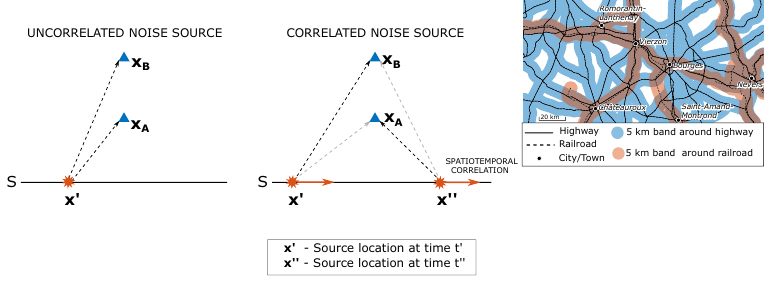
Figure 1. Geometry of a boundary S of uncorrelated, impulsive sources (see Equation (1)) versus a time-ordered train of impulsive sources (see Equation (4)). Blue triangles denote receivers and source locations are represented by orange stars. Orange arrows in the source boundary indicate the presence of a spatiotemporal correlation of sources along the boundary. The top-right panel shows the main roads (solid black) and railways (black dashes) within an area of about 9000 km 2 around Bourges, France. A zone of 5 km on either side of each road (blue) and railway (orange) highlights the prevalence of near-field traffic noise. The bottom panel shows oblique waves breaking against the coast of Skeleton Bay, Namibia. These are common examples of correlated noise